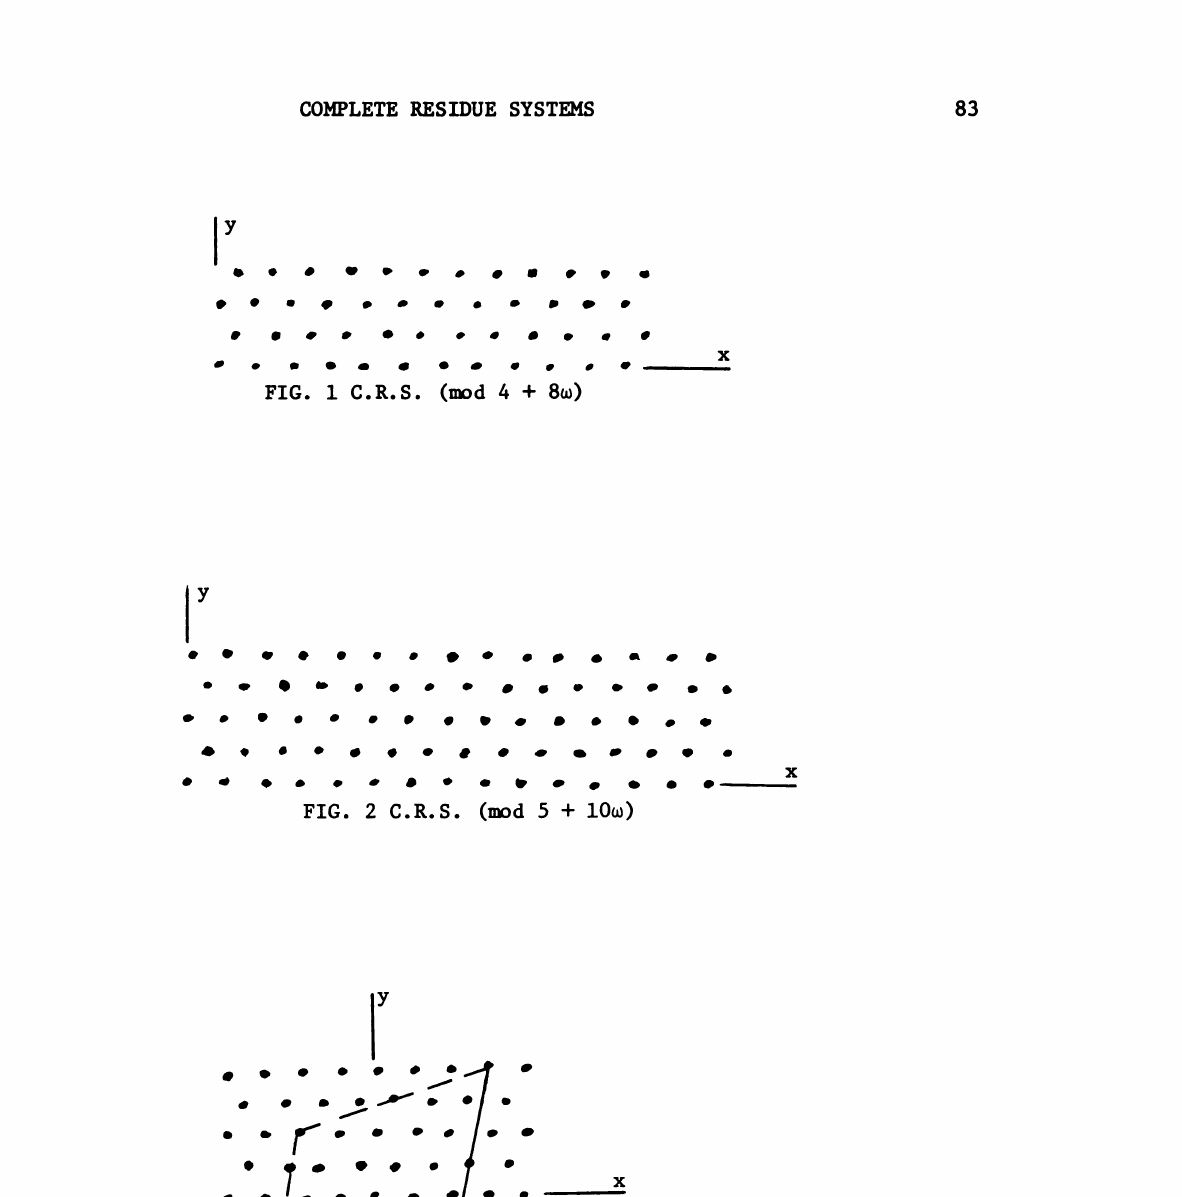
FIG. 3 C.R.S. (rood 4 +